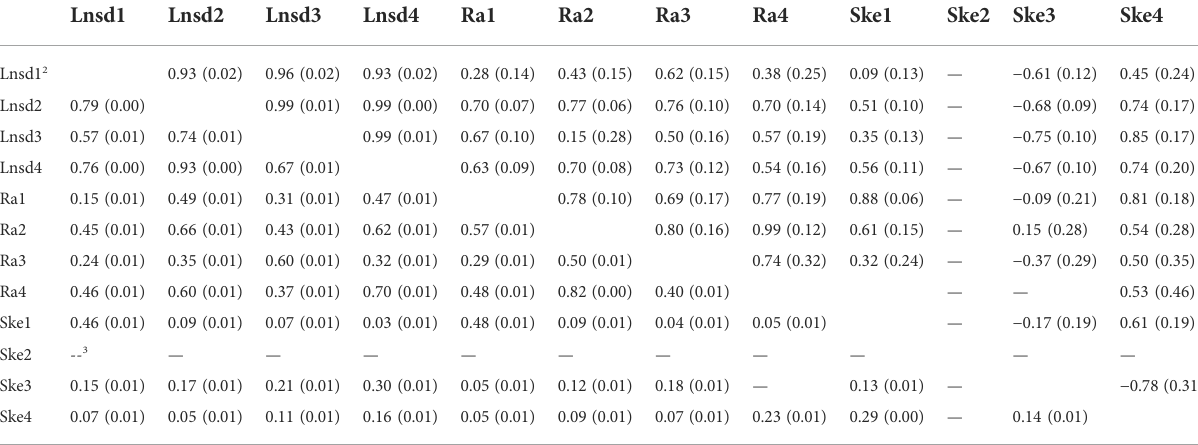
TABLE 3 Genetic (r G ) and phenotypic (r P ) correlations among variability traits 1 .